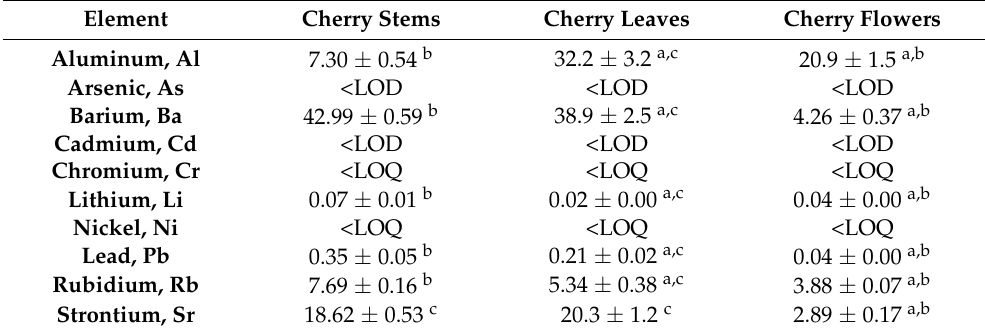
Table 2. Content of the 10 non-essential elements (mg/kg of dw) found in the Prunus avium L. by-products from the Saco variety from the Fund ã o region